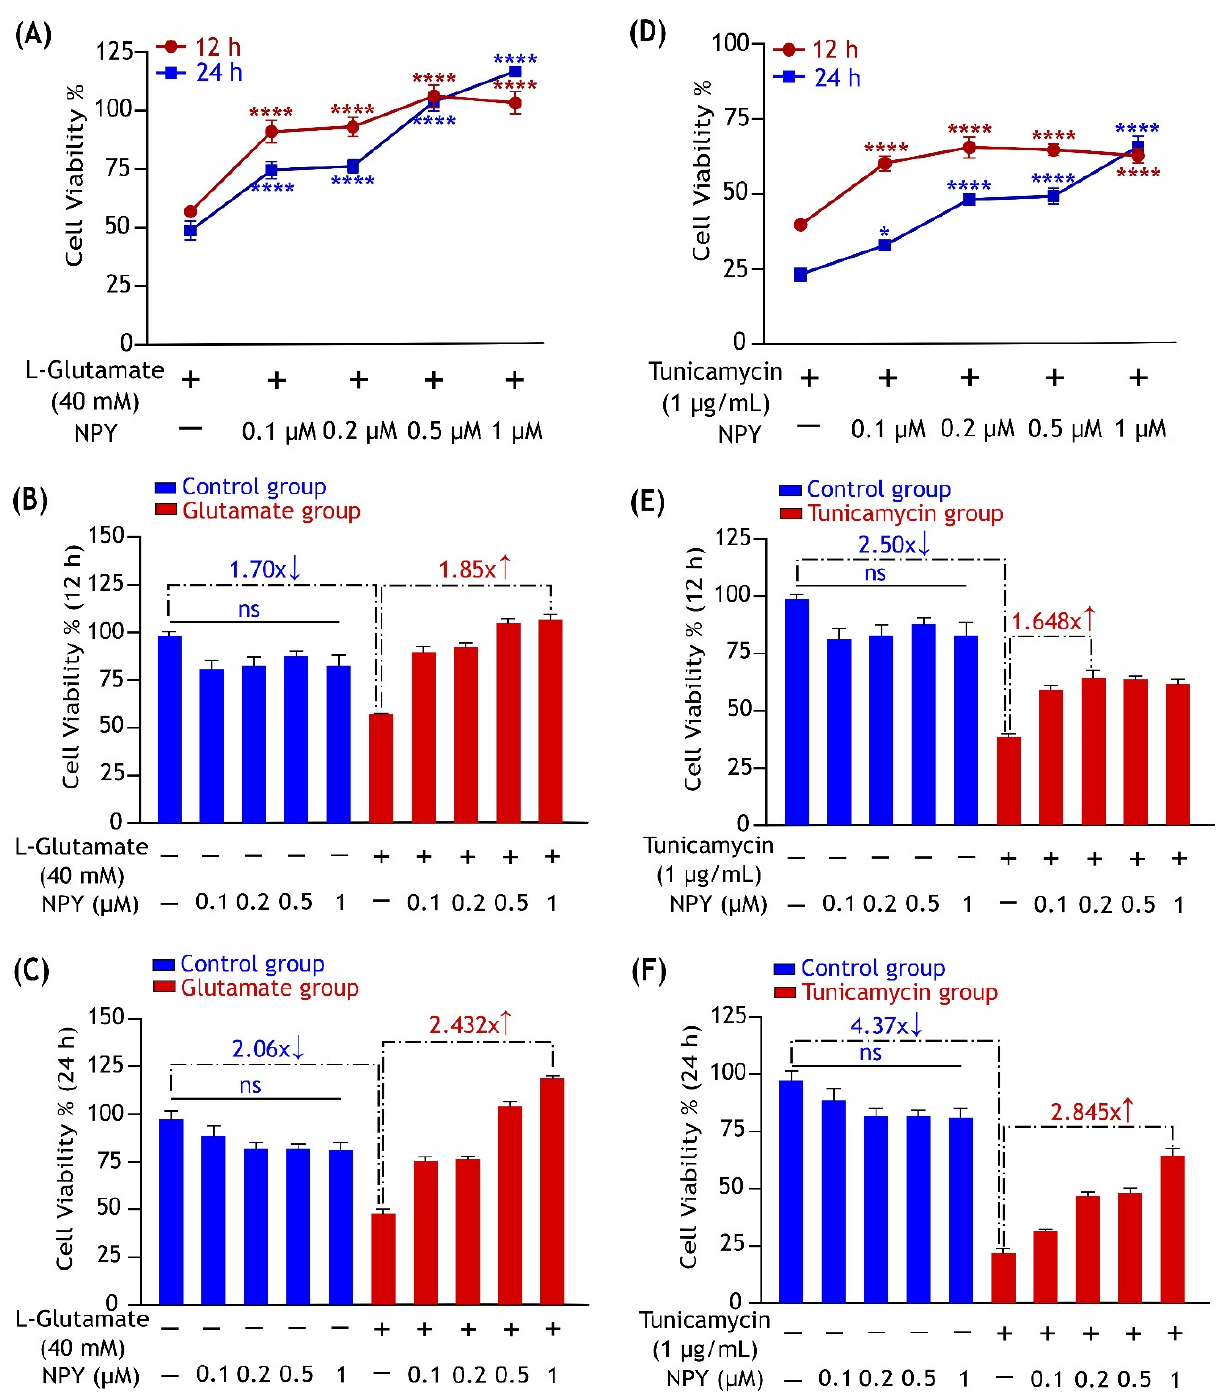
Figure 1. NPY treatment alleviates the cytotoxic effects of glutamate and tunicamycin in SH-SY5Y cell cultures. ( A ) The protective effects of NPY at different concentrations (0.1 µM, 0.2 µM, 0.5 µM, and 1 µM) on cell viability against L-glutamate (40 mM) induced toxicity. Data represent the mean ± SEM of three independent experiments (ns represent non-significant, F (4,50) = 70.15, **** p < 0.0001 for 12 h (red), **** p < 0.0001 for 24 h (blue), two-way ANOVA followed by Bonferroni’s post hoc test, n = 3). Bar graphs represent no significant changes in cell viability after treatment with NPY alone at 12 ( B ) and 24 h ( C ), as well as the fold change difference between the control and glutamate group and between glutamate and glutamate + NPY group showing the highest cell viability. ( D ) The protective effects of NPY at different concentrations (0.1 µM, 0.2 µM, 0.5 µM, and 1 µM) on cell viability against tunicamycin (1 µg/mL) induced cell death. Data represent the mean ± SEM of three independent experiments (ns represent non-significant, F (4,50) = 19.22, **** p < 0.0001 for 12 h (red),